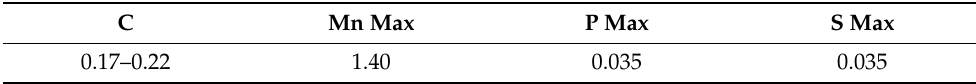
Table 1. Chemical composition of S235JR steel.